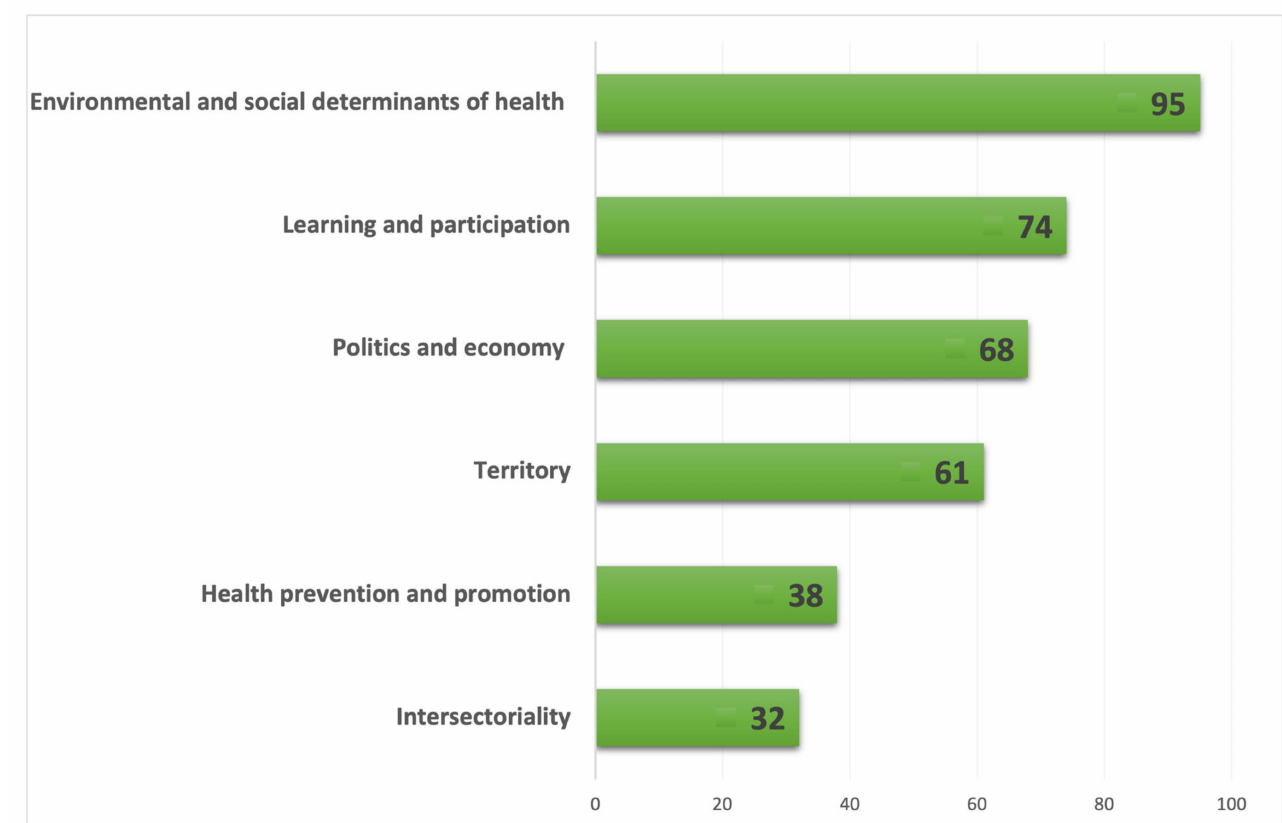
Figure 3. Frequency of narratives. Source: Authors’